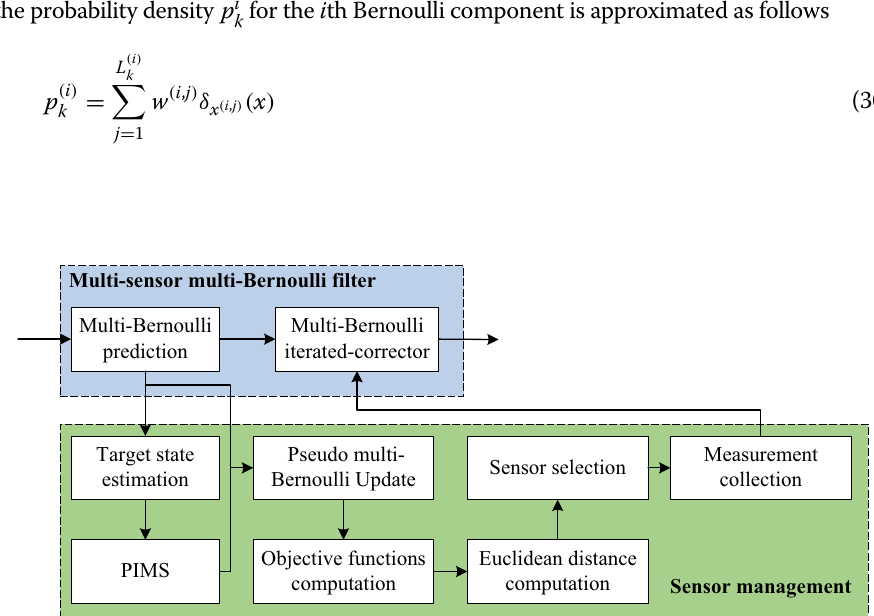
Fig. 2 Schematic diagram of the proposed MB MTT with sensor